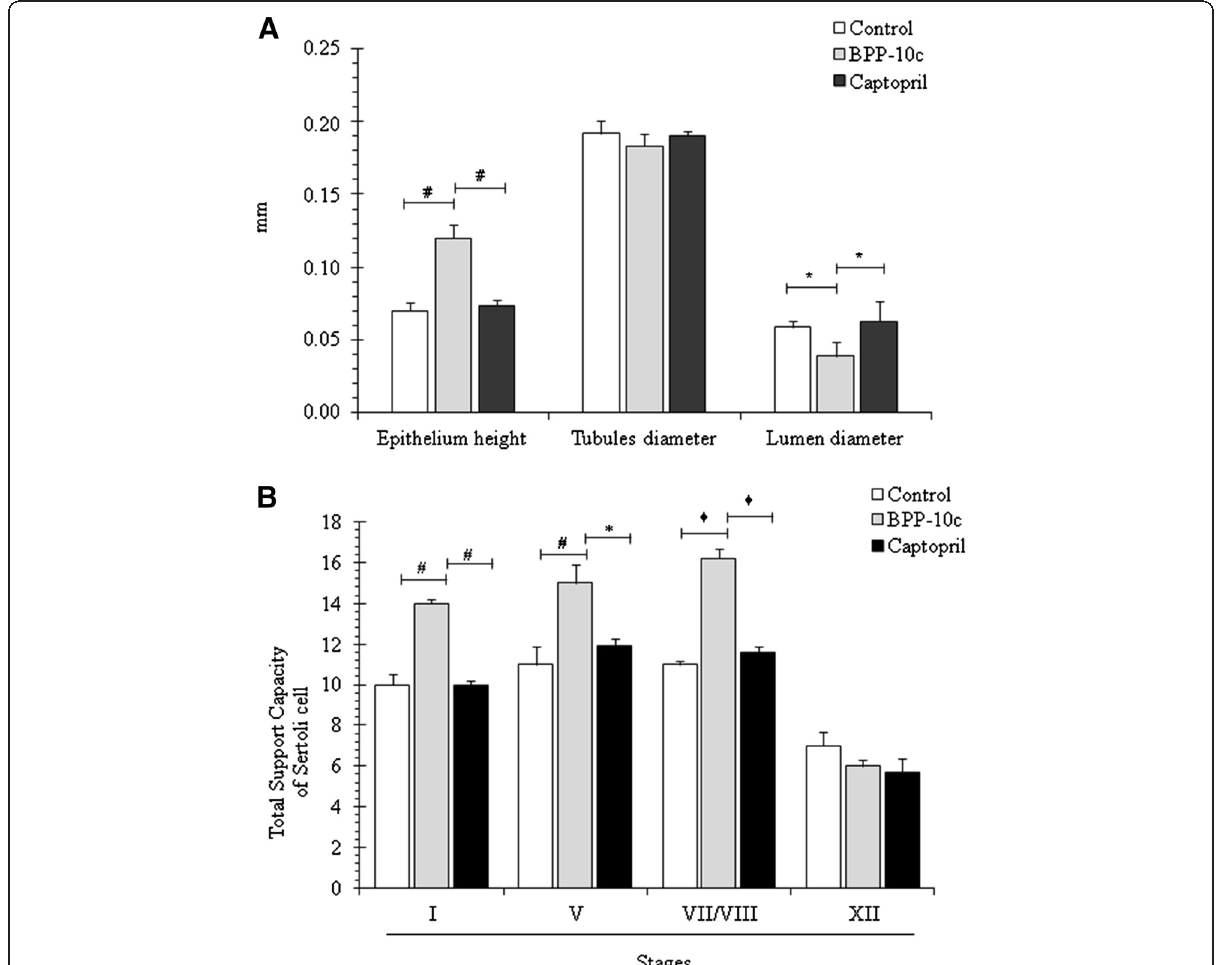
Figure 2 Morphometric analysis of the seminiferous epithelium of male adult mice treated with BPP-10c or captopril. (A) Morphometric aspects of the seminiferous tubules of control and treated animals (epithelium height, tubule diameter and lumen diameter). (B) Total support capacity of Sertoli cell increased during stages I, V, VII/VIII and XII of the seminiferous epithelium cycle when animals were treated with BPP-10c. Data are presented as mean ± SEM, and the criteria for statistical significance were set at p <